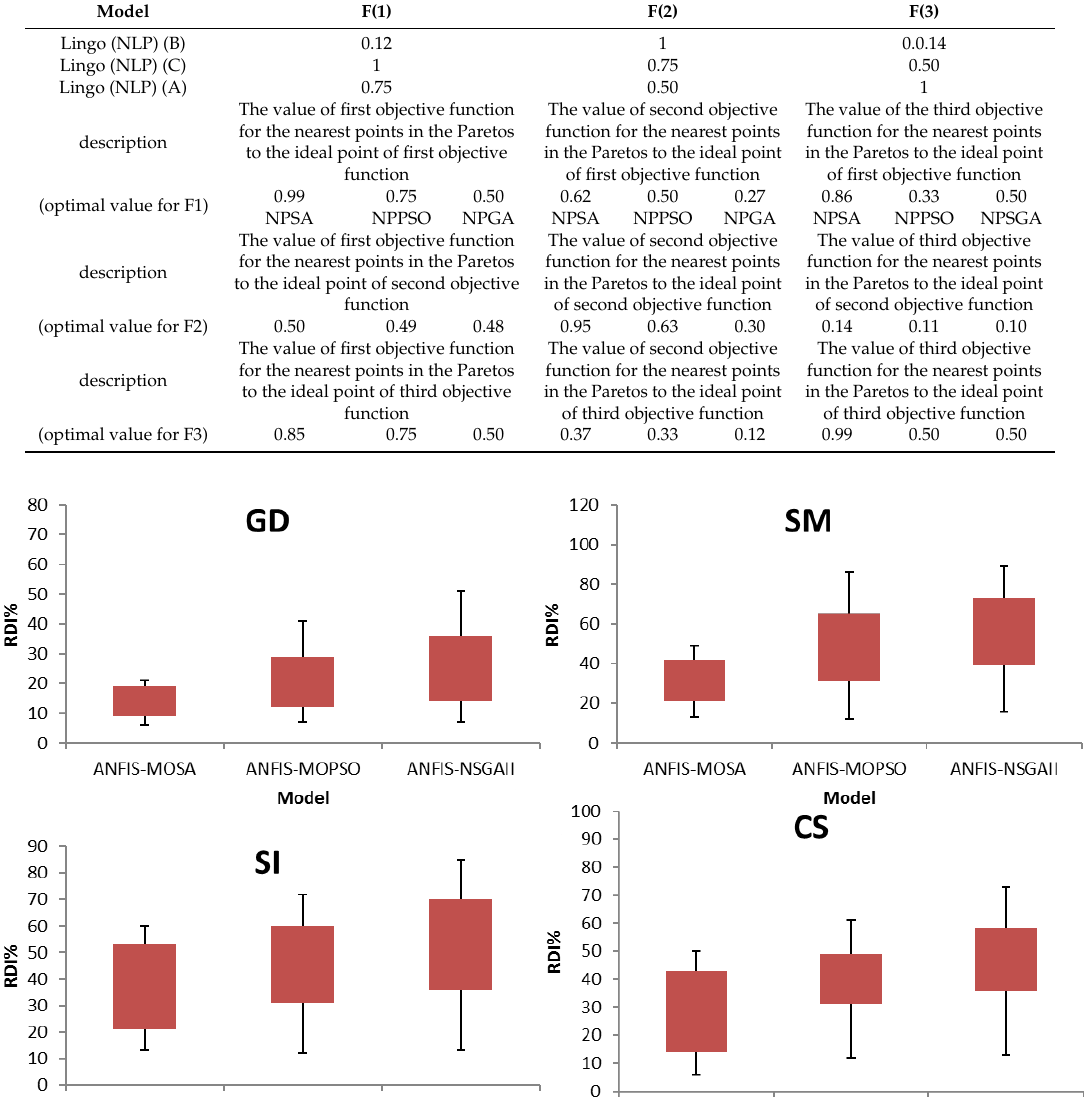
Table 5. Comparison of the condition of the nearest point of each Pareto with the best values of each objective function for Azarbayejan.